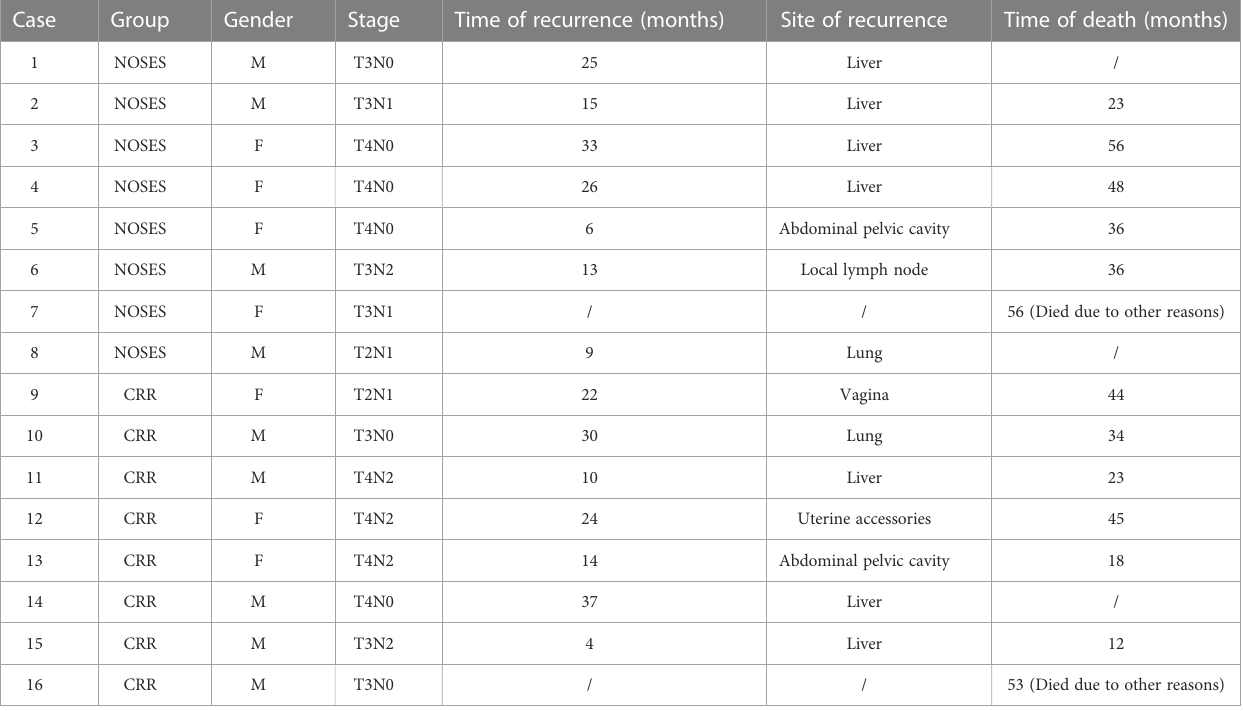
TABLE 3 Recurrence and end points.